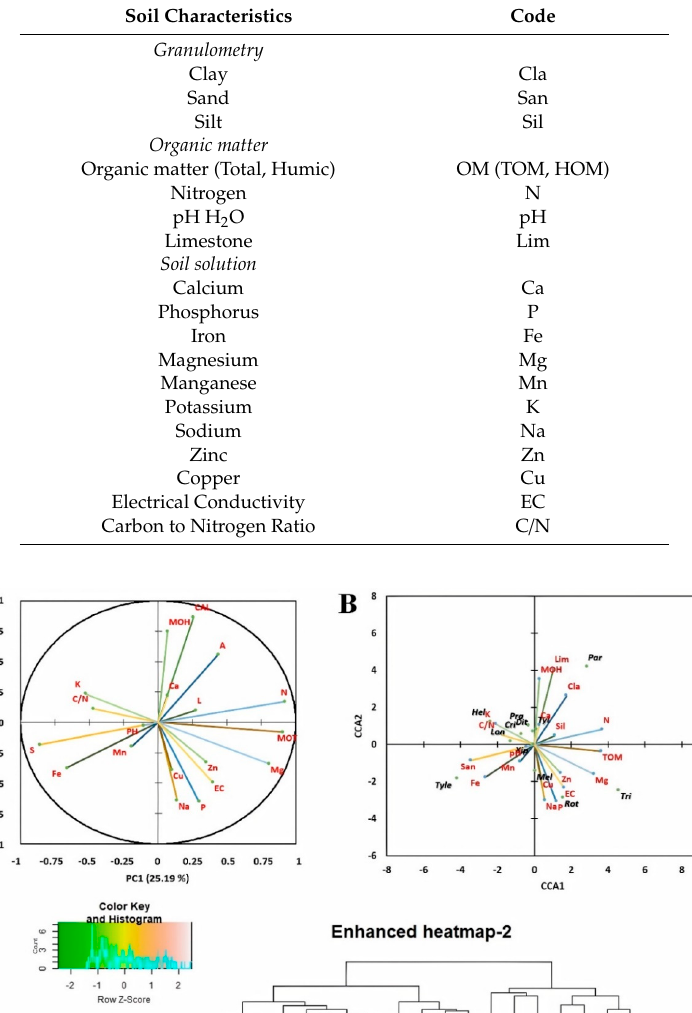
Table 6. Physico-chemical soil characteristics analyzed in the CCA and heatmap analyses, and their corresponding codes.